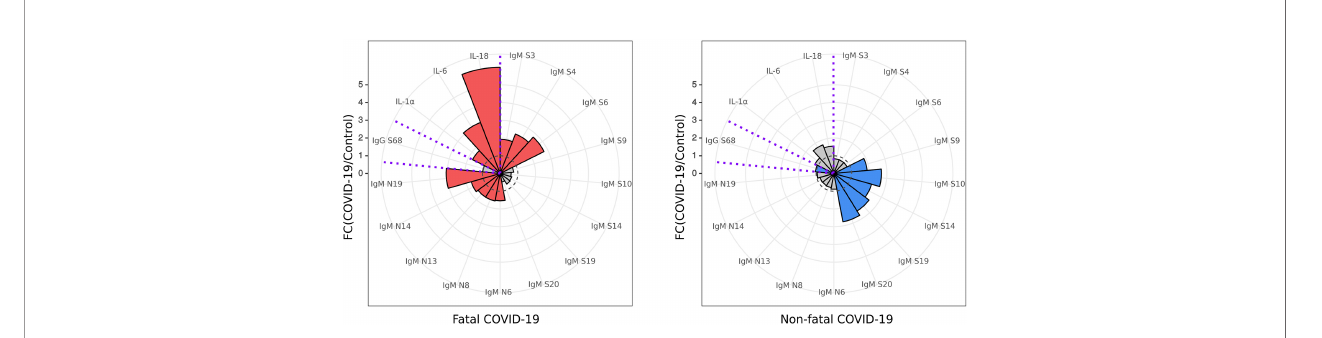
FIGURE 7 | Diagnostic panel for early identi fi cation of fatal COVID-19. Serum cytokine (IL-1 a , IL-6 and IL-18) level and reactivity of anti-SARS-CoV-2 IgM and IgG with S and N protein peptides selected for a diagnostic panel for early identi fi cation of fatal COVID-19. Red – cytokine level and SARS-CoV-2 peptide reactivity in fatal COVID-19; Blue – cytokine level and SARS-CoV-2 peptide reactivity in non-fatal COVID-19. Dotted line – fold change = 1, level in control. Data is presented as fold change – mean value of cytokines in COVID-19 divided by mean of cytokines